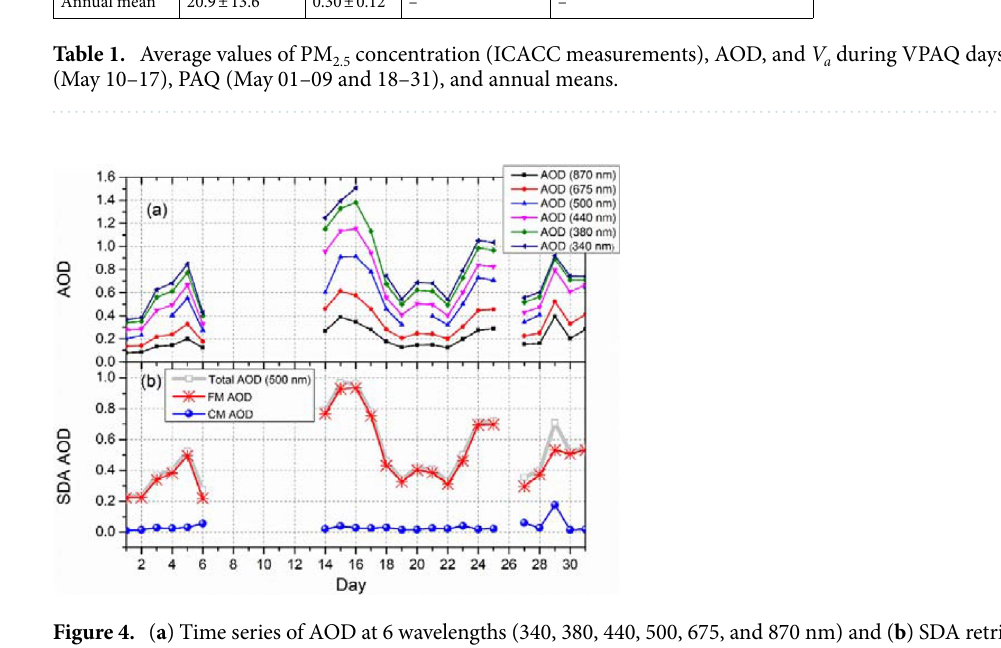
Figure 4. ( a ) Time series of AOD at 6 wavelengths (340, 380, 440, 500, 675, and 870 nm) and ( b ) SDA retrievals of the FM and CM contributions to the total AOD at 500